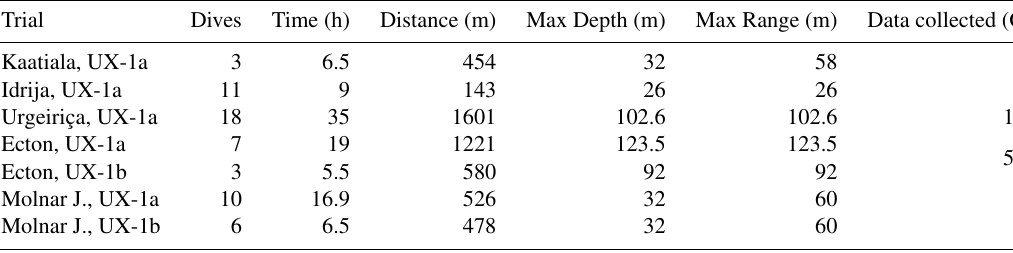
Table 2. Five pilots in numbers. Two different robots (UX-1a and UX-1b with slightly different instruments were tested).